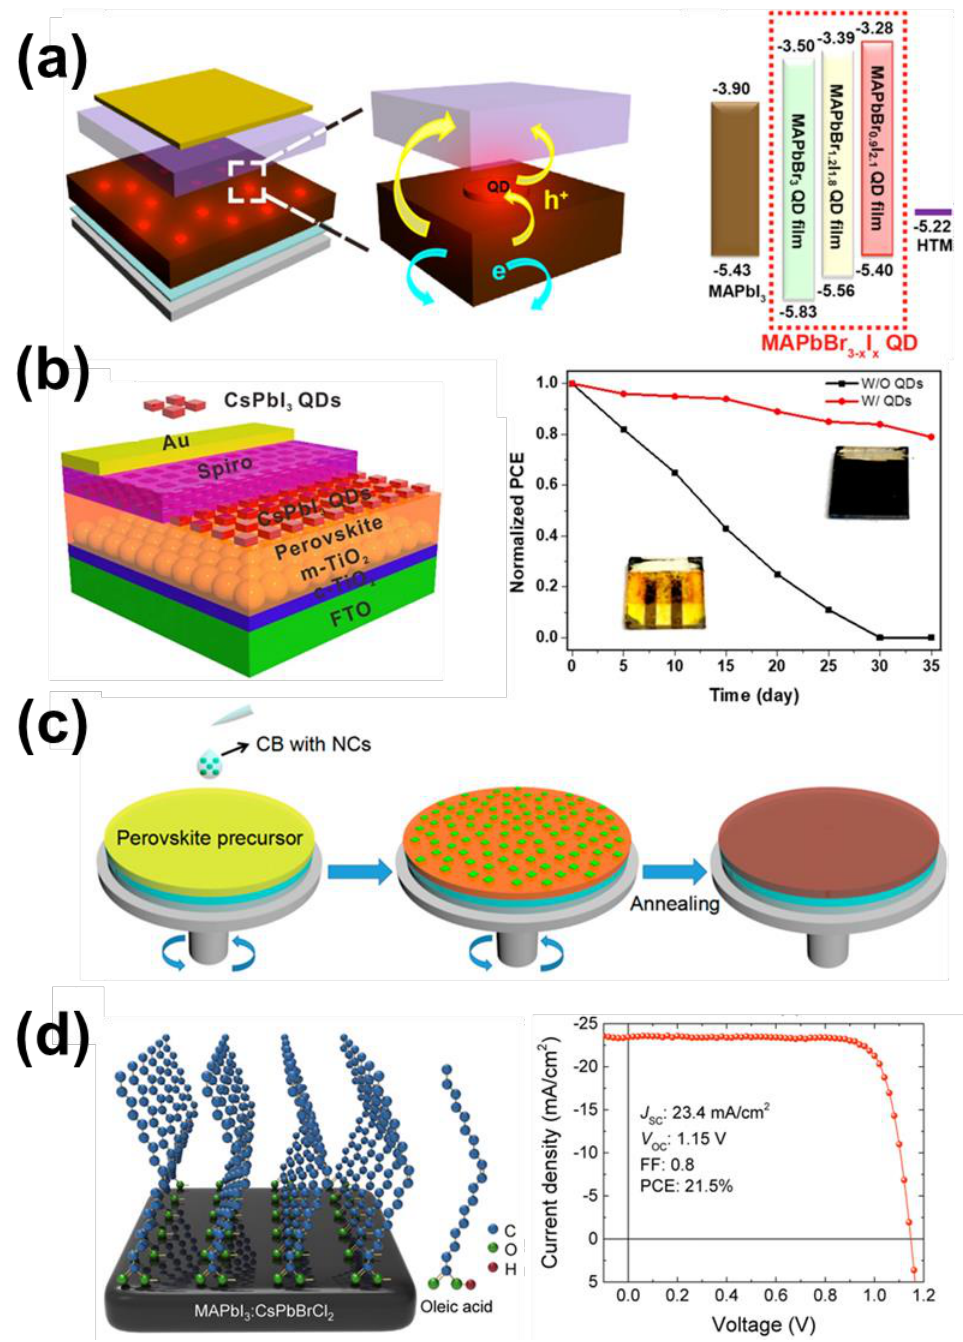
Figure 9. ( a ) Schematic illustration of the perovskite solar cell device structure and energy diagram of each material in the perovskite solar cell device, with energy levels in eV [72]. Copyright 2016 American Chemical Society. ( b ) Structure diagram of PSCs with CsPbI 3 NC interface engineering and dark storage stability of PSCs without and with the CsPbI3 NC interface layer. The insets are digital photos of PSC devices stored in ambient air for 35 days [73]. Copyright 2018 Springer Nature. ( c ) Schematic diagram of the deposition method for the perovskite film with CsPbBr 3 NCs; the green dots represent CsPbBr 3 NCs [74]. Copyright 2017 American Chemical Society. ( d ) Schematic illustration of the uniform elemental distribution across the MAPbI3 film and self-assembly of the OA molecules on the surface of the MAPbI 3 film. Note that the elements from NCs uniformly distribute in the MAPbI 3 thin film, and the thickness of the ligand and MAPbI 3 layers are not drawn to scale. In addition, J-V is the best device with 0.25 wt% of NCs in antisolvent [2]. Copyright 2019 Elsevier.